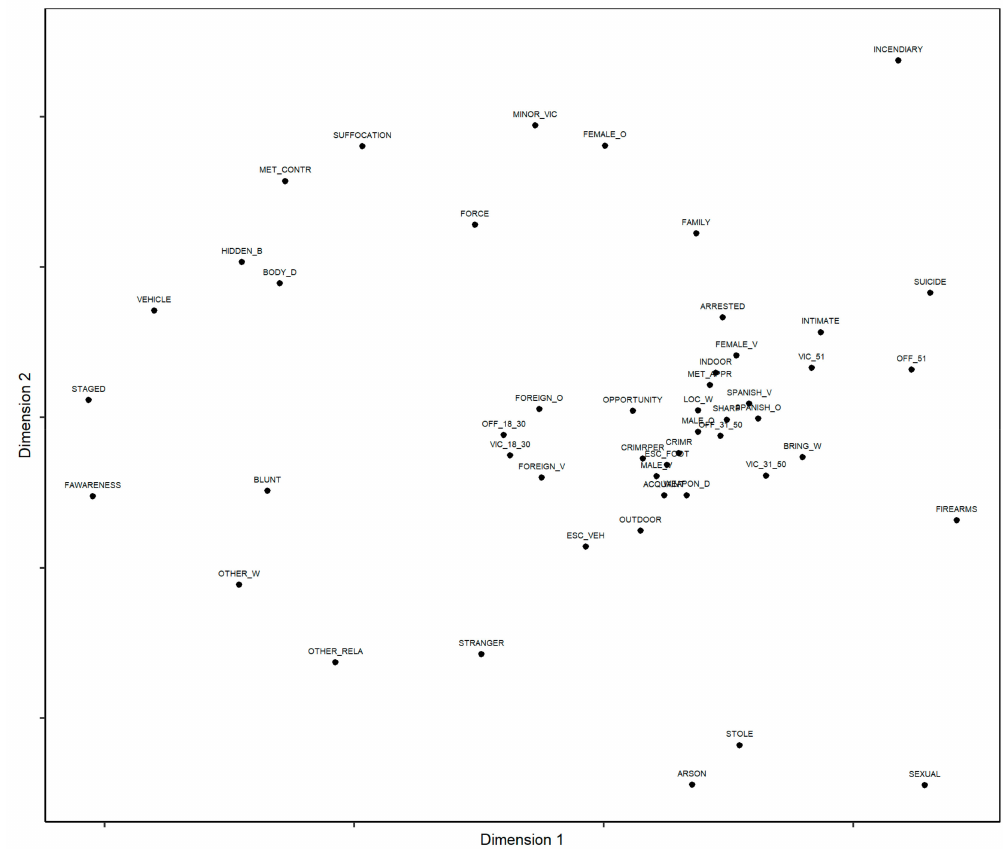
Figure 1. Bidimensional map of the nonmetric multidimensional scaling